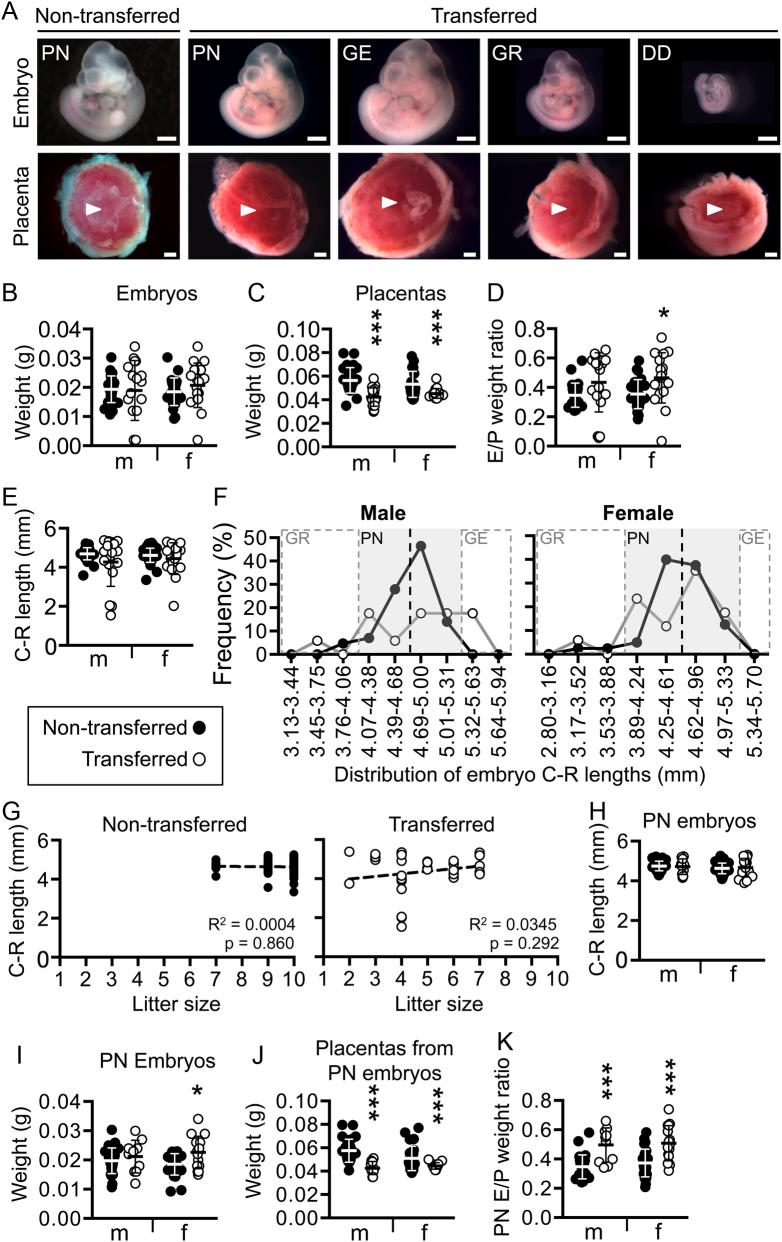
Blastocyst transfer in mice results in small placentas with a potential for increased efficiency at E10.5. (A) Images of embryos and placentas from non-transferred and transferred conceptuses at E10.5. Embryonic phenotypes shown include phenotypically normal (PN), growth enhanced (GE), growth restricted (GR), and developmentally delayed (DD) as determined by crown-rump lengths and somite pair counts. Arrowhead indicates where the allantois (i.e. the umbilical cord) was attached to the placenta. Scale bars: 500 μm. (B, C, D and E) Graphs showing (B) embryo weights, (C) placenta weights, (D) embryo:placenta (E/P) weight ratios, and (E) embryo crown-rump (CR) lengths in all non-transferred (black circles) and transferred (white circles) conceptuses at E10.5. Values are shown for male (m) and female (f) conceptuses (n = 17–43) and data are presented as mean ± s.d. Independent t test, *P < 0.05, ***P < 0.001. (F) Frequency distribution curves of embryo CR lengths as determined by sex for non-transferred (black solid line) and transferred (grey solid line) embryos. Only embryos staged as E10.5 were considered. Black dotted lines indicate the mean crown-rump length for non-transferred embryos. Lengths that fall within the grey shading indicate conceptuses that are grossly phenotypically normal (PN). Grey dotted lines indicate two s.d.s from the control mean. Crown-rump lengths that were greater than two s.d.s below the mean were considered GR and greater than two s.d.s above the mean were considered GE. (G) Linear regression analysis of litter size versus embryo CR length in control (black circles) and transferred (white circles) conceptuses. A line of best fit is indicated (dotted line). (H, I, J and K) Graphs showing parameters for PN conceptuses only including (H) embryo CR length, (I) embryo weight, (J) placenta weight, and (K) E/P weight ratios in non-transferred (black circles) and transferred (white circles) conceptuses. Data are presented as mean ± s.d. and is shown for male (m) and female (f) conceptuses (n = 10–43 conceptuses). Independent t tests, P < 0.05, ***P < 0.001.